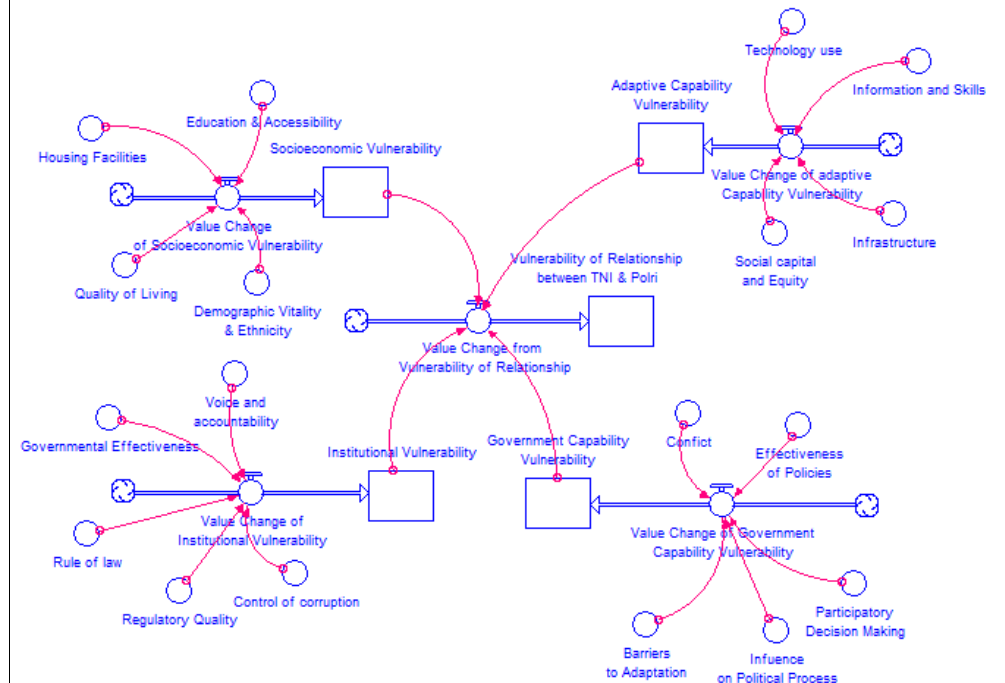
Fig. 6. Stock flow diagram of Vulnerability evaluation scores for power relationship of TNI-Polri post-1998 reformation